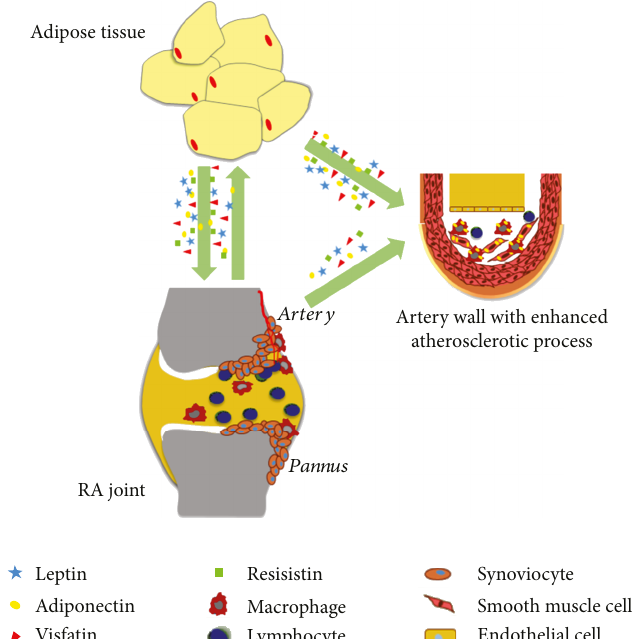
Figure 1: Schematic role of adipocytokines on the relationship among adipose tissue, rheumatoid arthritis, and atherosclerotic